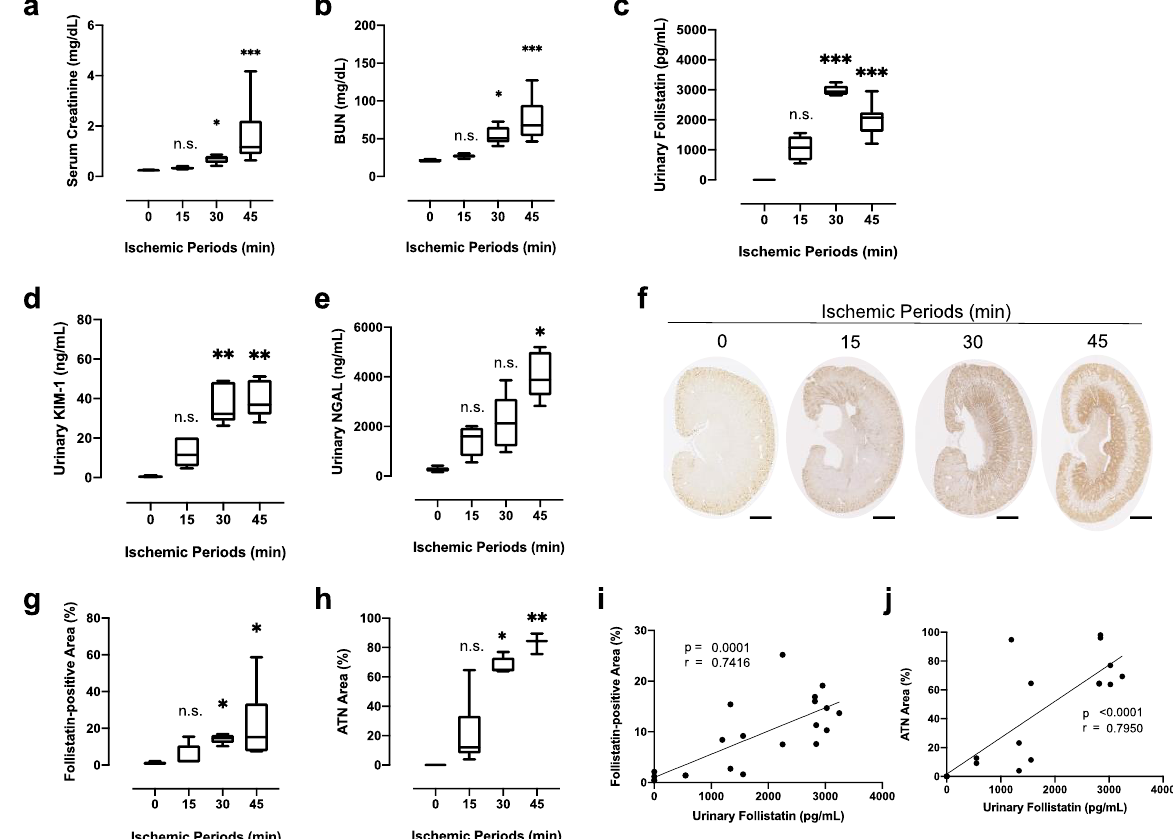
Figure 5. Correlation between urinary follistatin and severity of kidney damage. ( a , b ) Serum creatinine and BUN in rats with renal ischemia at 24 h after reperfusion. N.S., not significant, * p < 0.05, *** p < 0.001 vs. 0 h. ( c – e ) Urinary follistatin, urinary NGAL, and urinary KIM-1 in rats with renal ischemia for the indicated periods at 24 h after reperfusion. N.S., not significant, * p < 0.05, ** p < 0.01, *** p < 0.001 vs. 0 h. ( f ) Localization of follistatin (brown) in kidneys after renal ischemia for 15, 30, and 45 min was examined by immunostaining. Bar = 2 mm. ( g ) Quantitative analysis of follistatin-positive area. Five randomly selected fields of the kidney were assessed at × 100 magnification. The follistatin-positive area was measured by ImageJ 1.53a. Values are the means ± S.E. ( n = 5–6). N.S., not significant, * p < 0.05 vs. 0 h. ( h ) Semiquantitative analysis of the histological changes induced by renal ischemia. The ATN area was calculated as described in Section 2. N.S., not significant, * p < 0.05, ** p < 0.01 vs. 0 h. ( i , j ). Correlation between urinary follistatin and follistatin-positive area ( i ) or ATN area ( j ) at 24 h after reperfusion.